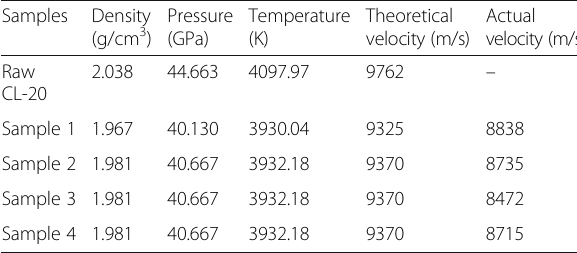
Table 2 Detonation performances of